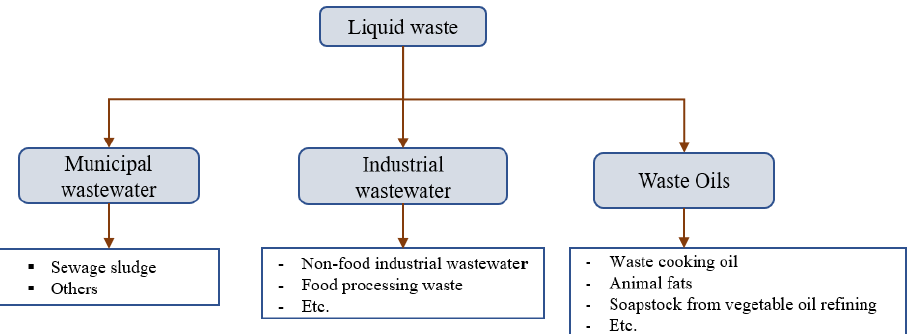
Figure 3. Classification of liquid biomass waste